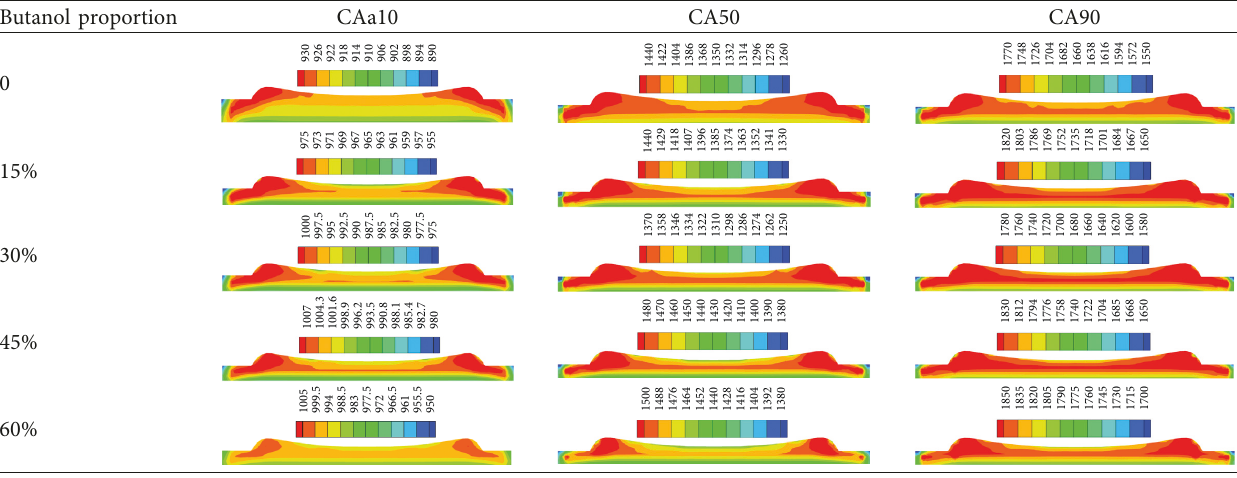
Table 5: The calculated temperature at different positions of the